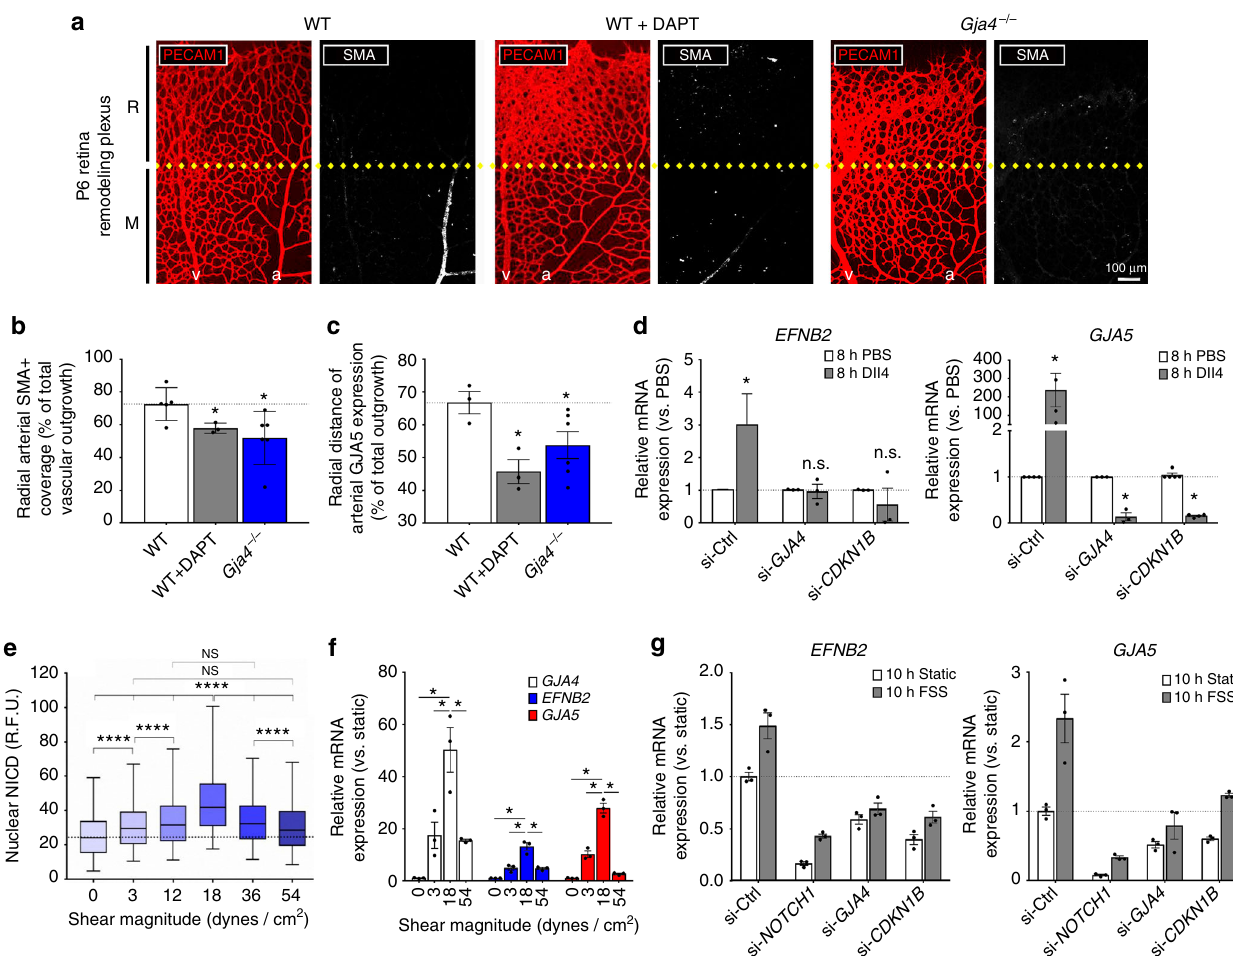
Fig. 6 FSS-NOTCH-GJA4-CDKN1B axis regulates arterial identity genes. a Disorganized or absent SMA investment was observed in Gja4 − / − and WT + DAPT mice, compared to WT controls. (Colors: PECAM1 (red), SMA (white); scale bar: 100 µ m; symbols: a = artery, v = vein, R = remodeling, M = mature). b Radial SMA investment of arteries, as well as c radial distance of GJA5 (Cx40) expression, were reduced in Gja4 − / − and DAPT-treated animals (mean radial distance as % of total vascular outgrowth ± SEM vs WT; n = 3 (WT + DAPT; WT, GJA5), n = 4 (WT, SMA), n = 6 ( Gja4 − / − ); one-way ANOVA: p = 0.03 (SMA), p = 0.04 (GJA5); asterisks indicate p < 0.05 in post hoc t -tests vs. WT). d DLL4 activation of NOTCH signaling upregulated EFNB2 (EphrinB2) and GJA5 , and this effect was abolished with si- GJA4 or si- CDKN1B (mean relative mRNA expression ± SEM vs. PBS; n = 3 (si- GJA4 ; si- CDKN1B, EFNB2 ), n = 4 (si-Ctrl, GJA5 ; si- CDKN1B , GJA5 ), n = 4 (si-Ctrl, EFNB2 ); Students ’ t -test: p = 0.02 (si-Ctrl, EFNB2 ), p = 0.04 (si-Ctrl, GJA5 ), p = 0.0005 (si- GJA4 , GJA5 ), p < 0.0001 (si- CDKN1B , GJA5 )). e NOTCH activation was maximal with 1 h exposure to 18 dynes/cm 2 shear (mean NICD R.F.U. ± SEM; n = 7000 cells, representative of N = 3). f Expression of GJA4 (Cx37), GJA5 (Cx40) and EFNB2 (EphrinB2) were also maximal at 18 dynes/ cm 2 (mean relative mRNA expression ± SE; n = 3, representative of 4 experiments). g Knockdown of NOTCH1, GJA4 or CDKN1B reduced basal and 10 h FSS-induced upregulation of EFNB2 and GJA5 (mean relative mRNA expression ± SEM vs. Static; n = 3 technical replicates; representative of two biological